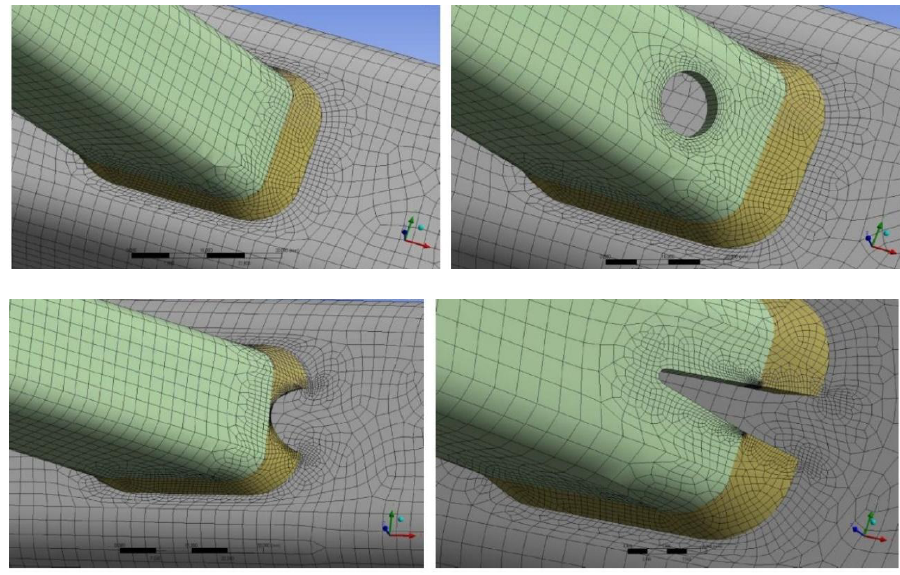
Figure 3. Mesh models of holes and welds.